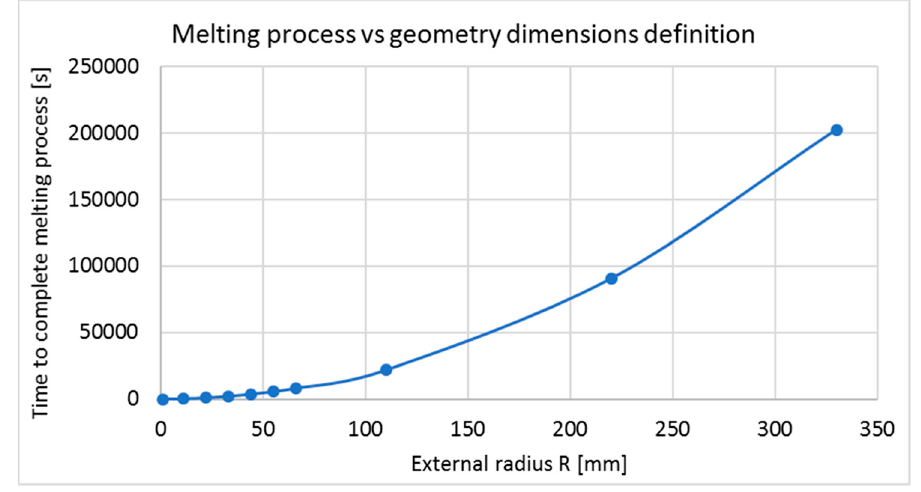
Figure 6. Time to complete the melting process in function of geometry dimensions.